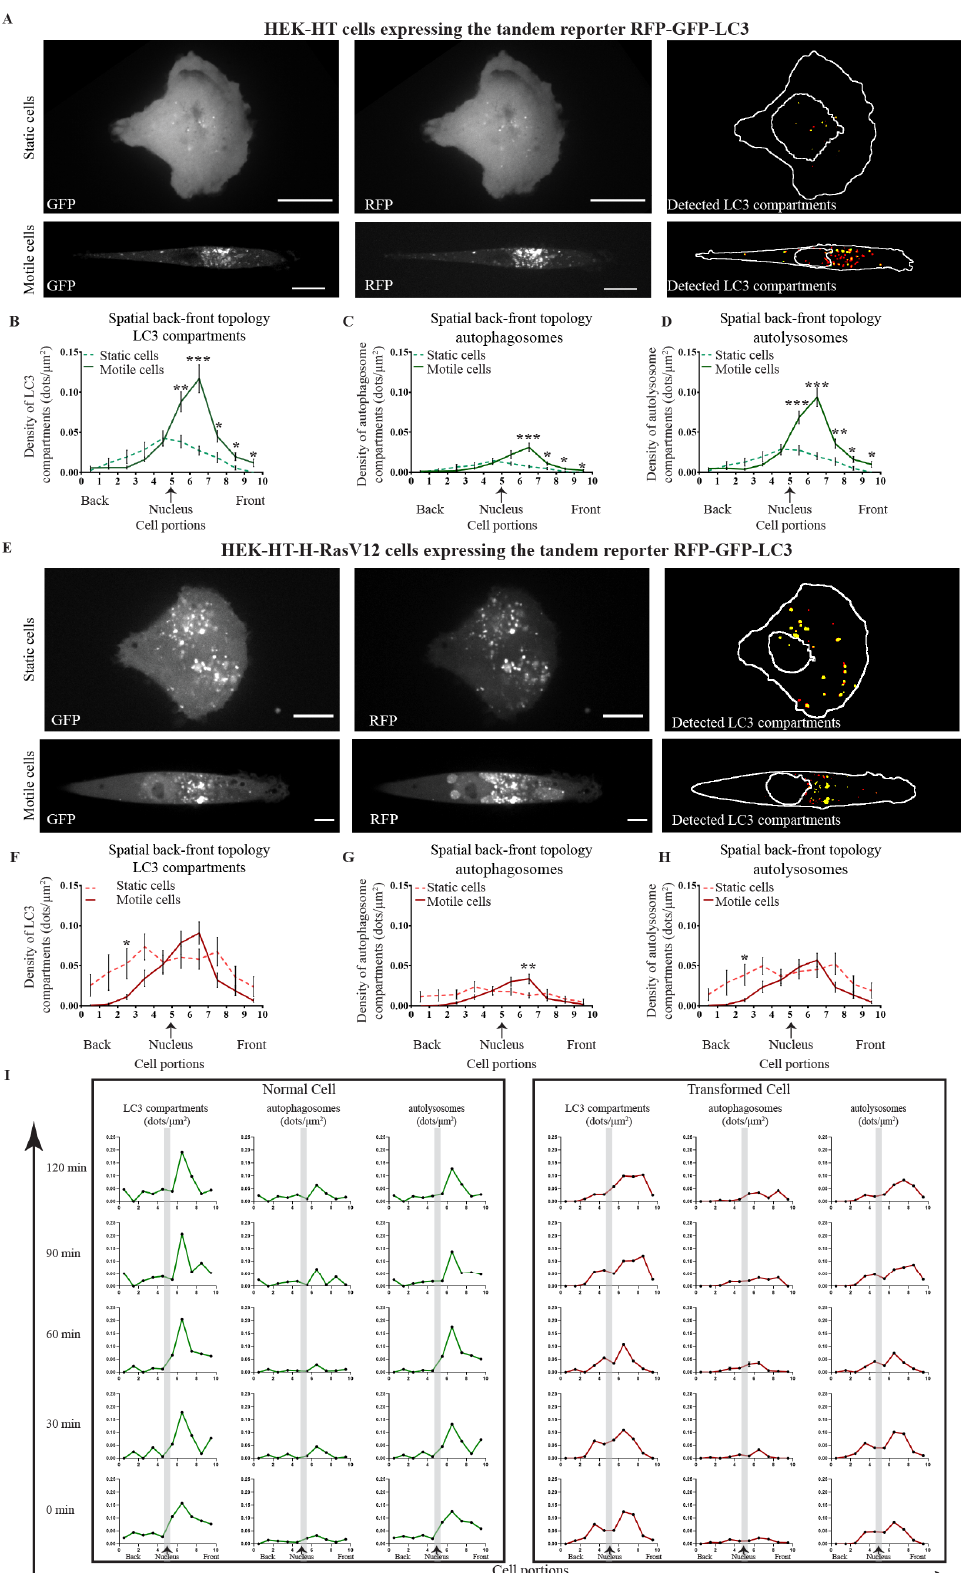
Figure 5. Spatial-temporal localization of LC3 compartments (autophagosomes and autolysosomes) in normal (HEK-HT) and transformed (HEK-HT-H-RasV12), static and motile cells. ( A ) Normal cells. Representative images on crossbow (static) and line (motile) micro-patterns in GFP and RFP channels. The right panel shows the overlay of detected LC3